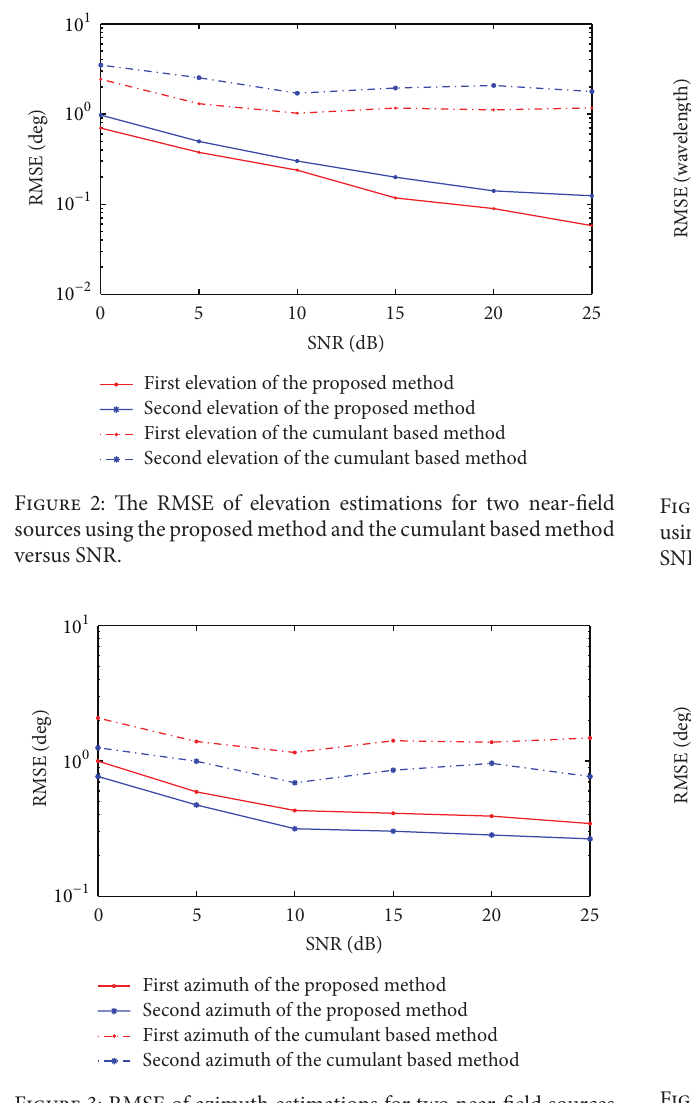
Figure 3: RMSE of azimuth estimations for two near-field sources using the proposed method and the cumulant based method versus SNR.